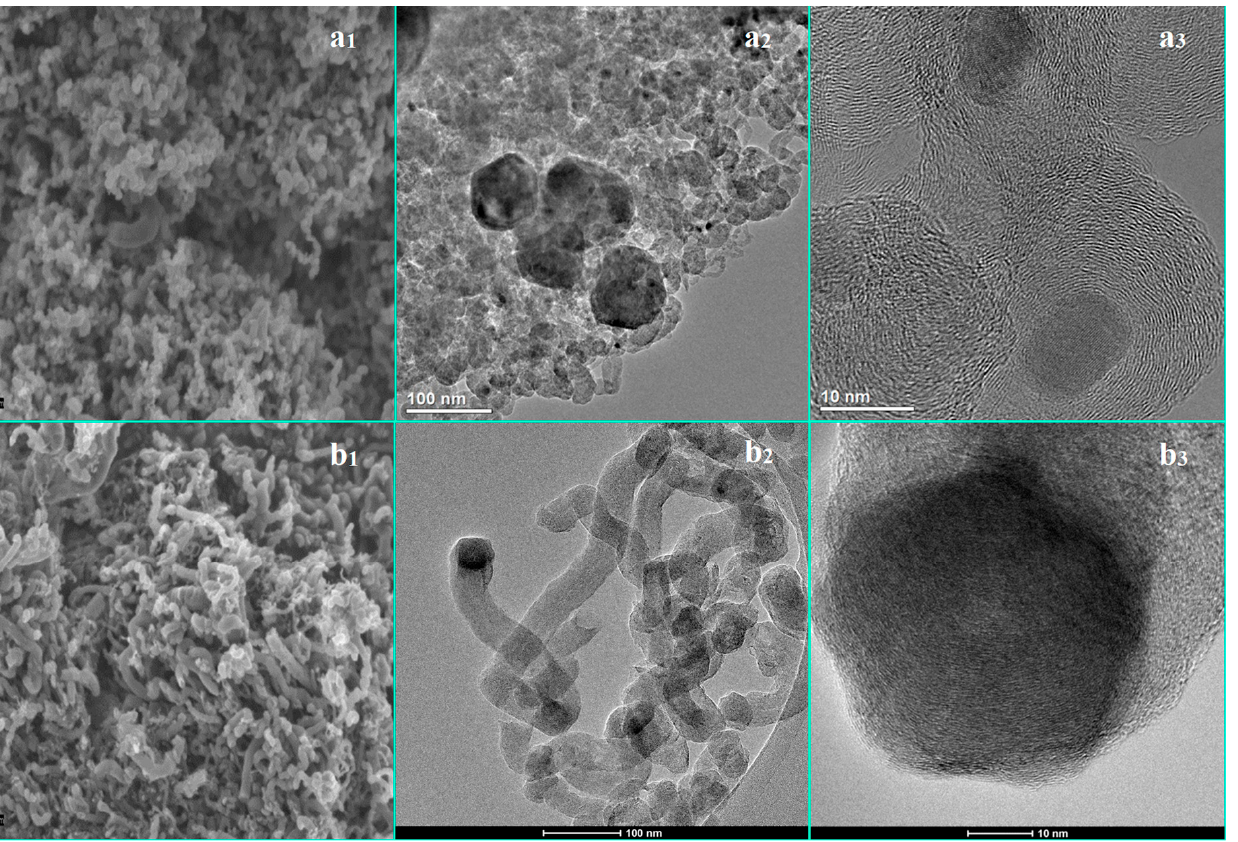
Figure 8. Microscopic analysis of KNi/MnO x catalyst after 18 h of SRE reaction at 420 °C for ( a ) H 2 O/EtOH molar ratio of 12/1 and ( b ) H 2 O/EtOH molar ratio of 4/1. SEM images ( a 1 , b 1 ) and TEM images ( a 2 , a 3 , b 2 , b 3 ).